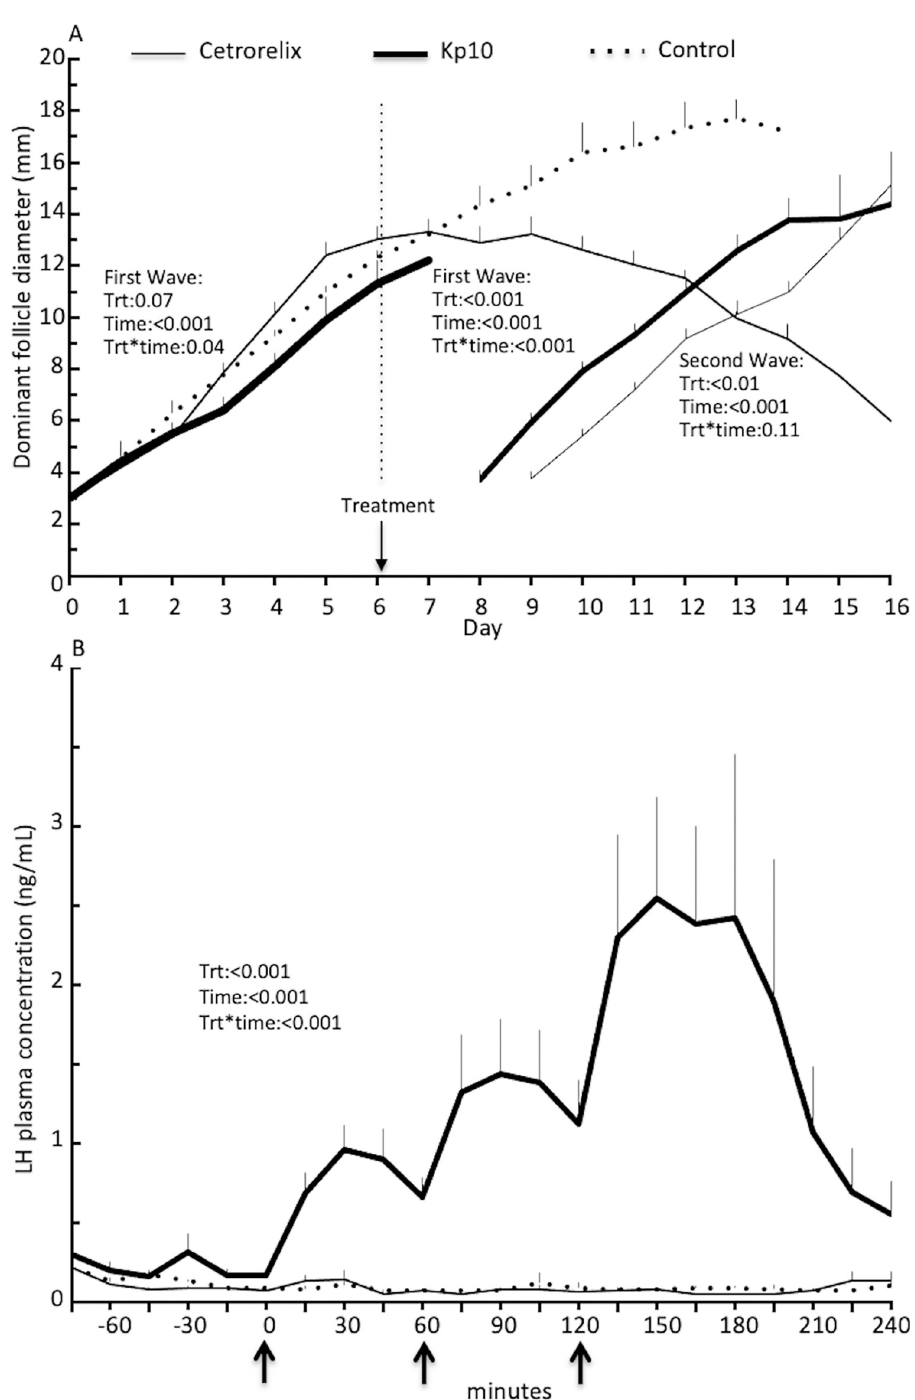
Fig 5. Ovarian follicular dynamic and LH profile in heifers treated in the Experiment 2. A) Growth profile of dominant follicle in pubertal heifers treated at Day 6 of follicular wave (day of wave emergence = Day 0) with human Kisspeptin-10 given as three injections of 15 mg at 60 minutes interval over a 2-hour period (Kp10 group, n = 5). Cetrorelix group (n = 5) was injected GnRH antagonist (Cetrorelix, 20 μ g/Kg body weight, intramuscular) 3 hours before kisspeptin treatment while the Control group (n = 5) was given three intravenous injections of normal saline. B) Plasma LH concentrations in Kp10, Cetrorelix and Control group heifers.